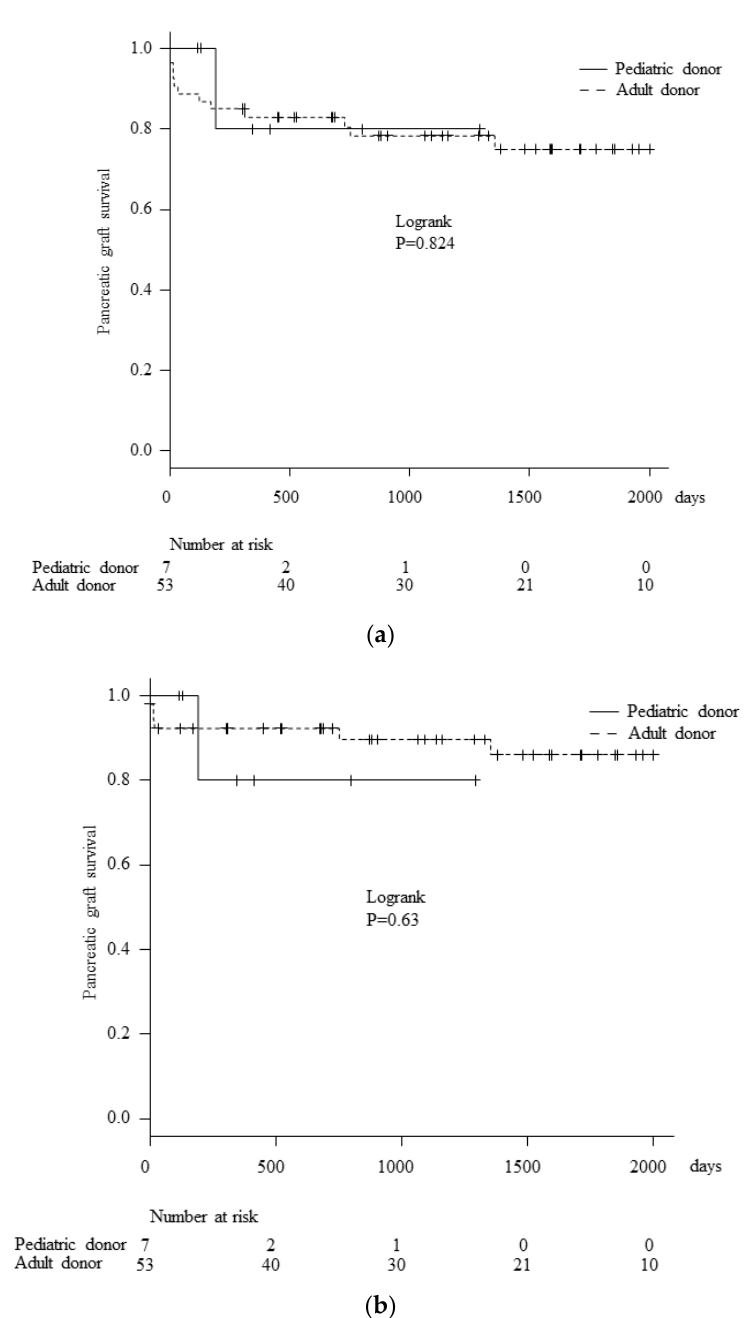
Figure 1. Comparison of pancreatic graft survival. There was no significant difference between the PD and AD groups in overall ( a ) or death-censored ( b ) pancreatic graft survival. Only one patient in the PD group experienced pancreatic graft loss due to rejection at six months post-transplantation. The graft function was well-maintained in the other cases.